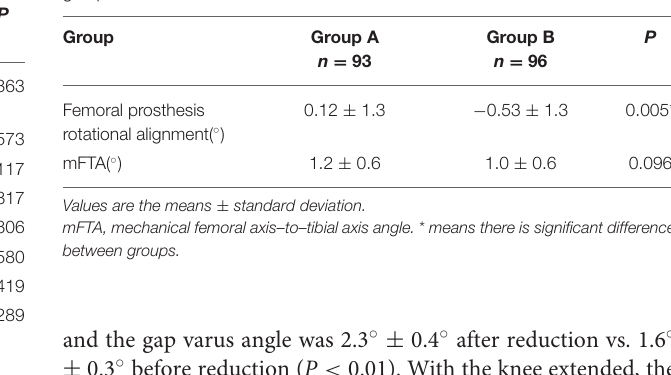
TABLE 4 | Comparison of postoperative imaging parameters between the two groups.